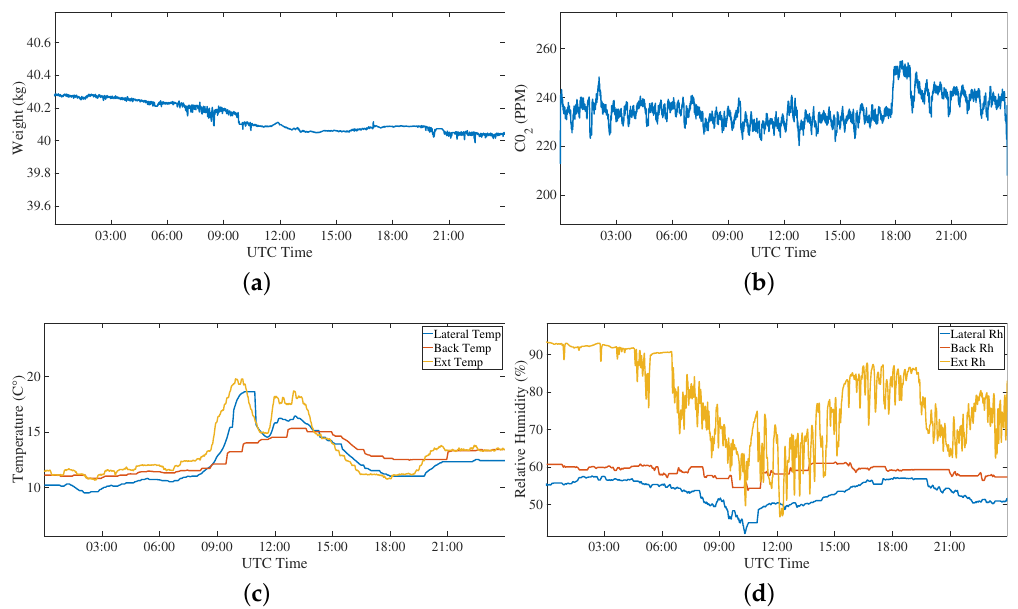
Figure 9. First event: normal activity of the bee hives monitored through the analysis of ( a ) weight, ( b ) CO 2 , ( c ) temperature, and ( d ) relative humidity variations measured over 24 h on 1 February 2018. During the winter, there is a small activity of the hive confirmed by the measured data.